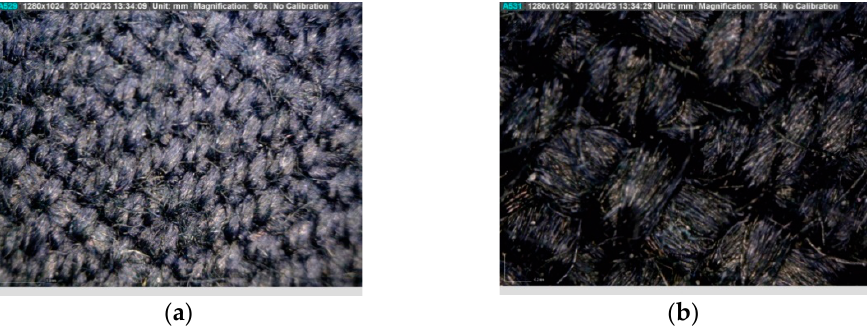
Figure 7. Undamaged sample: ( a ) magnification ×60 and ( b ) magnification ×184.